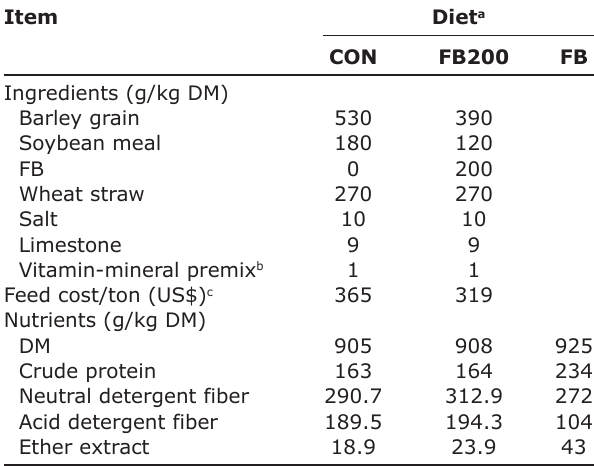
Table-1: Ingredients and chemical composition of diets containing FB fed to Awassi lambs. Item Diet a